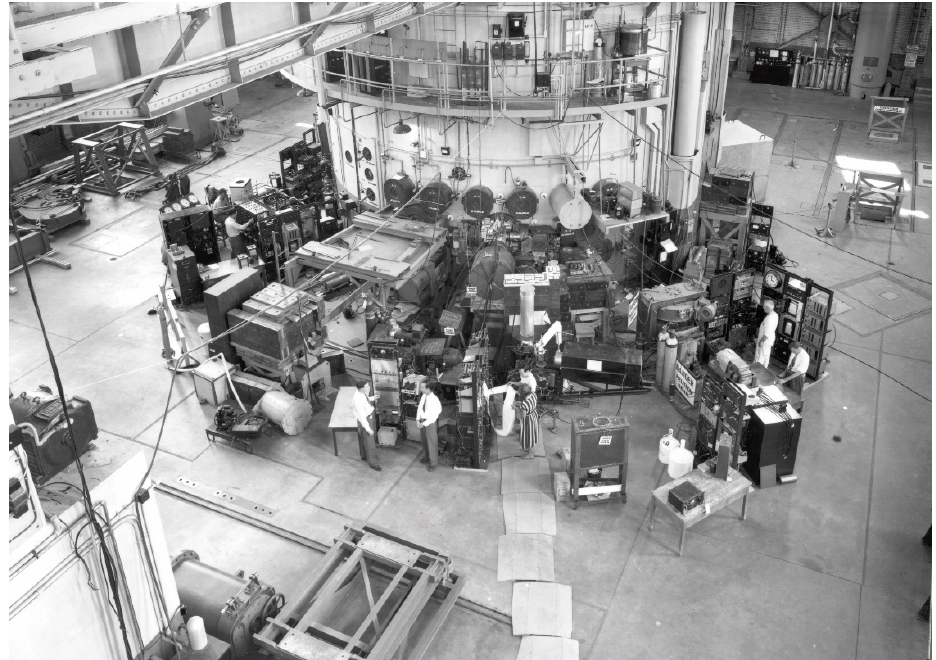
Figure 1. The main floor of the National Research Experimental (NRX) reactor at the Chalk River Laboratory about 1950. The powder spectrometer constructed by Donald Hurst and colleagues is visible near the center of the photograph. Most of the other equipment is concerned with nuclear physics or with physics of the neutron itself. For reasons of restricted space around the reactor, each heavily shielded apparatus is located at the end of a long tube. This figure is taken from Figure 1 of ref. [2] and reproduced by courtesy of Atomic Energy of Canada Limited. Copyright by the American Physical Society.